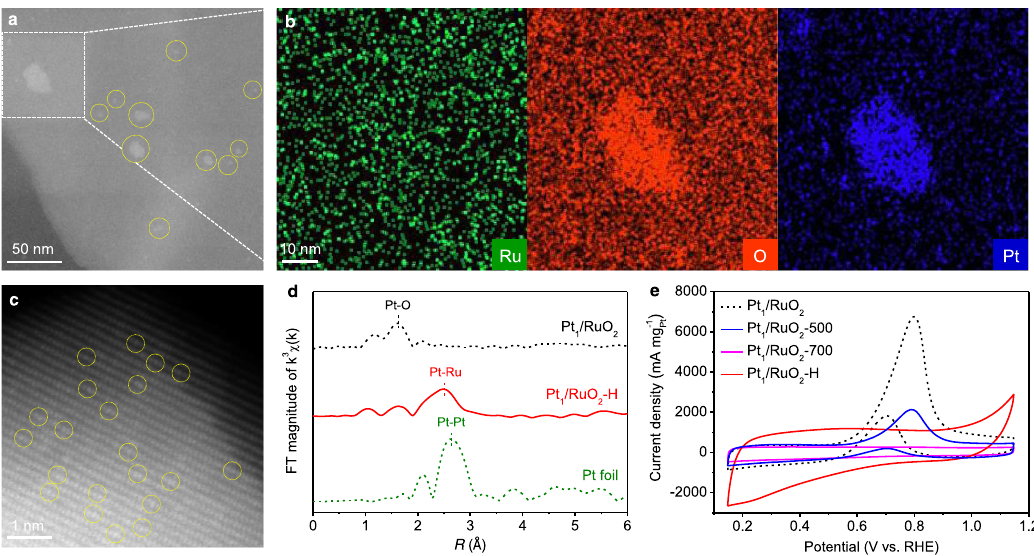
Fig. 4 Characterizations and MOR performance of Pt 1 /RuO 2 -500/Pt 1 /RuO 2 -700 and Pt 1 /RuO 2 -H in 0.1 mol L ‒ 1 KOH and 1 mol L ‒ 1 methanol solution at a scan rate of 50 mV s ‒ 1 . a Typical HAADF-STEM images of Pt 1 /RuO 2 -700. b Corresponding EDS-mapping images of enlargement in ( a ). c Typical HAADF-STEM images of Pt 1 /RuO 2 -H. d k 3 -weighted R-space Fourier transformed spectra from EXAFS of Pt 1 /RuO 2 -H. e MOR performance. The curves in Figs. 2b and 3b are replotted here for convenient comparison.